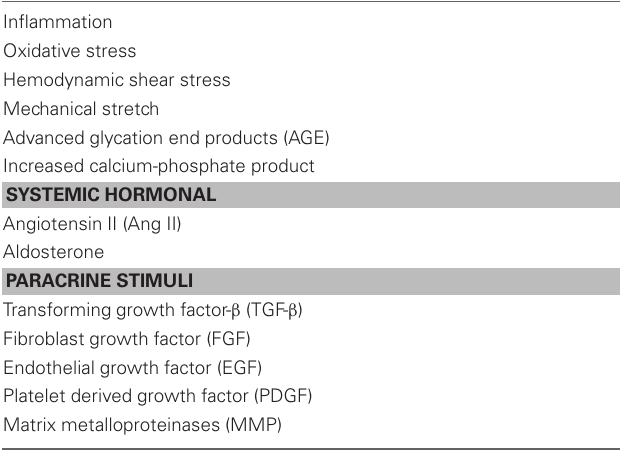
Table 1 | Stimuli for vascular smooth muscle phenotype